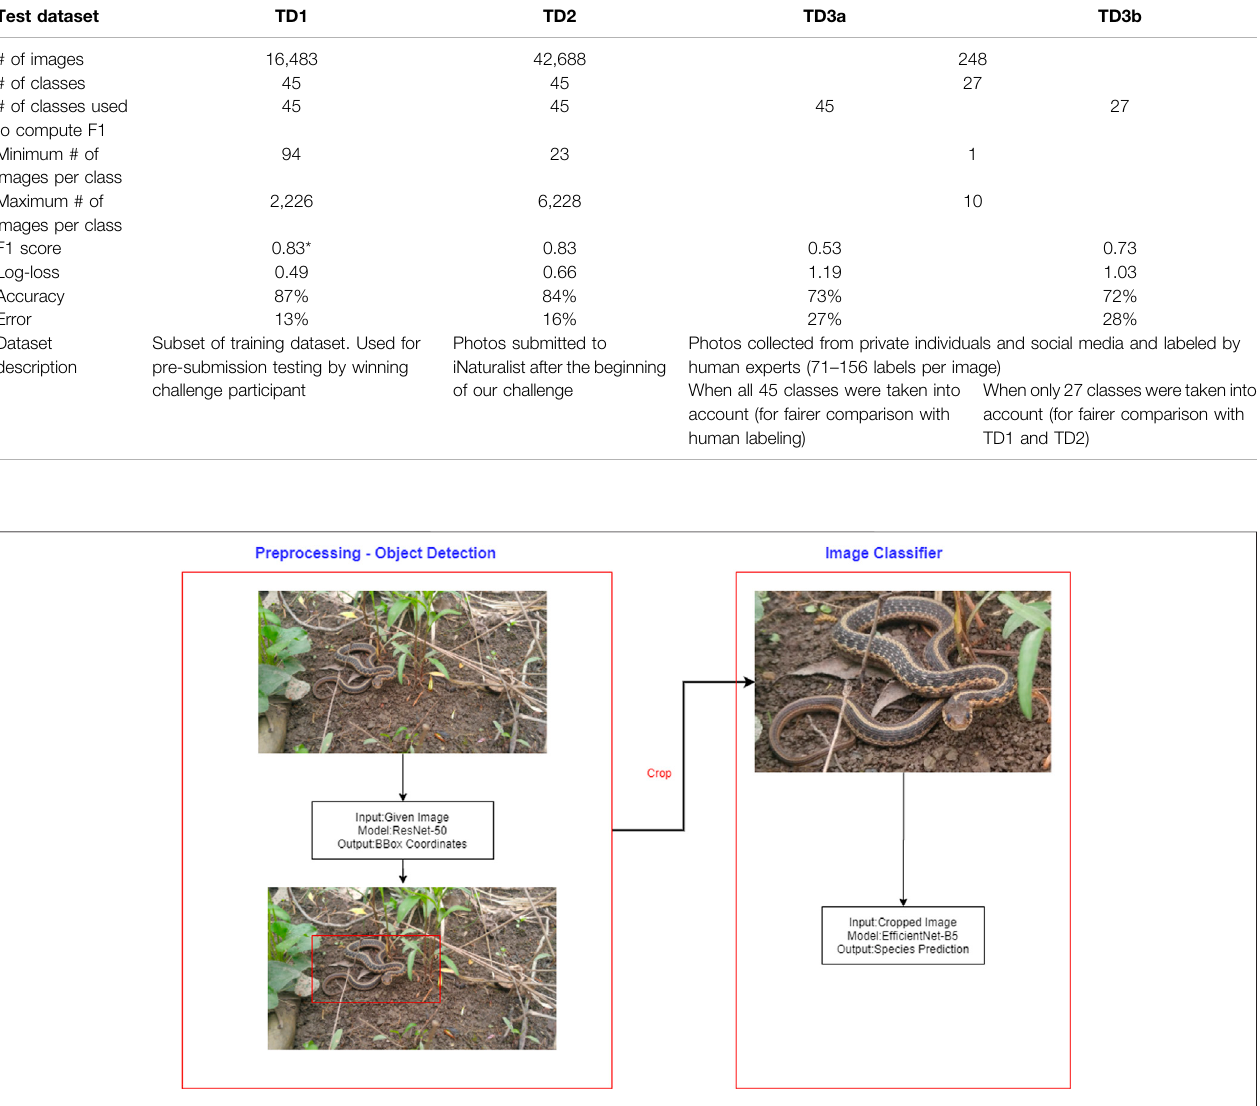
FIGURE 2 | Diagram of overall pipeline including both object detection and classi fi